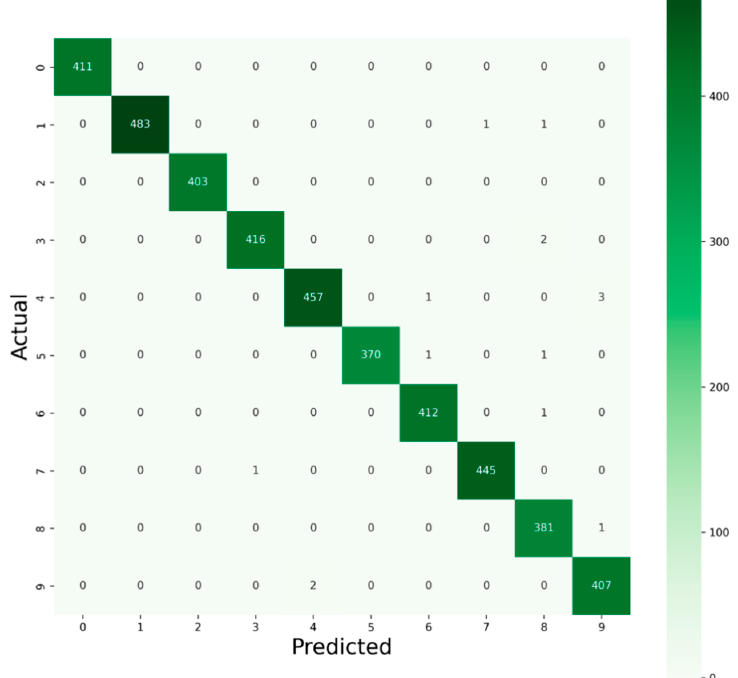
Figure 13. Confusion matrix of model M2 for 0–9 recognition.